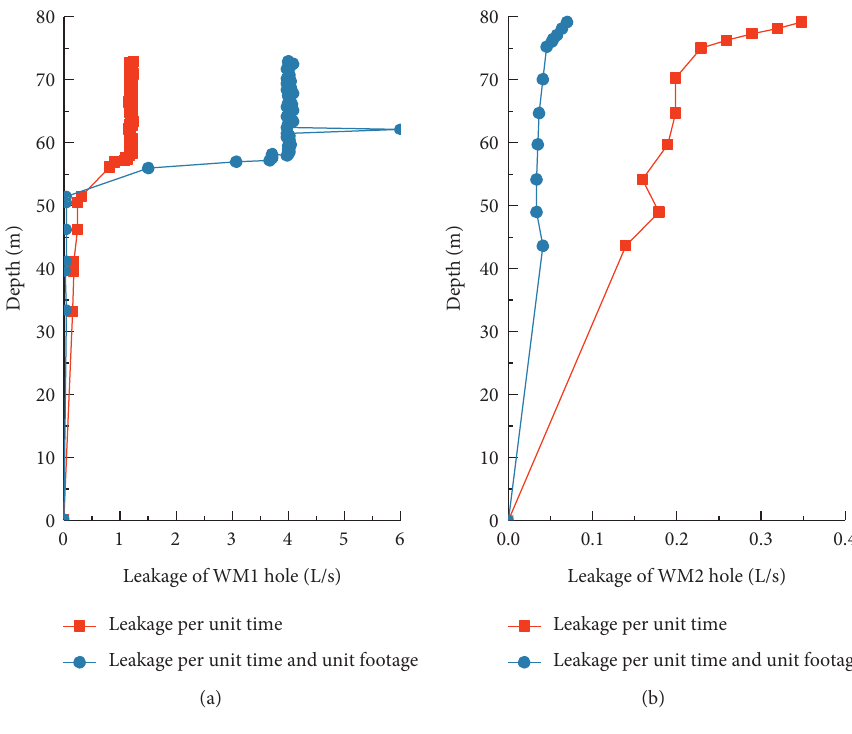
Figure 18: Change curve of drilling fluid